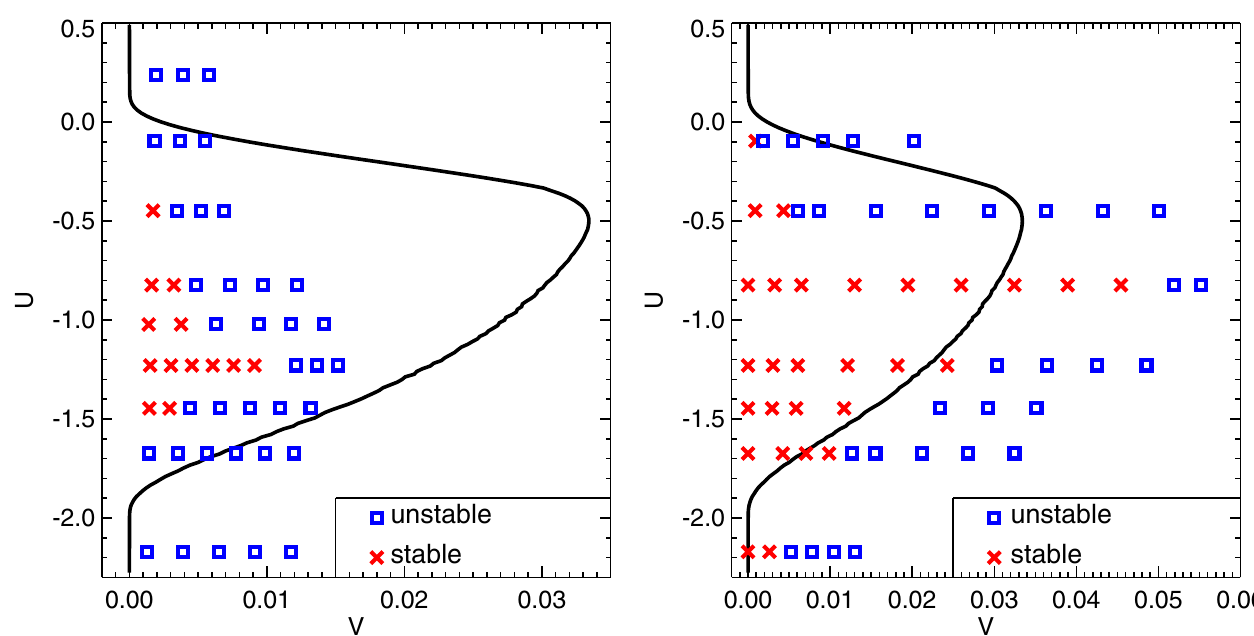
FIG. 6. (Color) Combination of nonlinear space-charge and an octupole with the advantageous polarity, Gaussian distribution; left: simulations with self-consistent space charge; right: simulated with frozen electric field. Symbols are results of simulation runs; lines are stability diagrams from the dispersion relation.